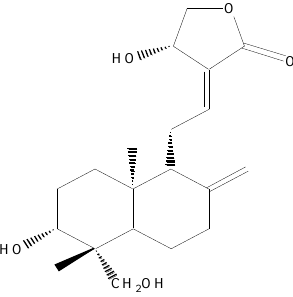
Figure 1.Chemical structure of andrographolide of bitter (Jarukamjorn and Nemoto,